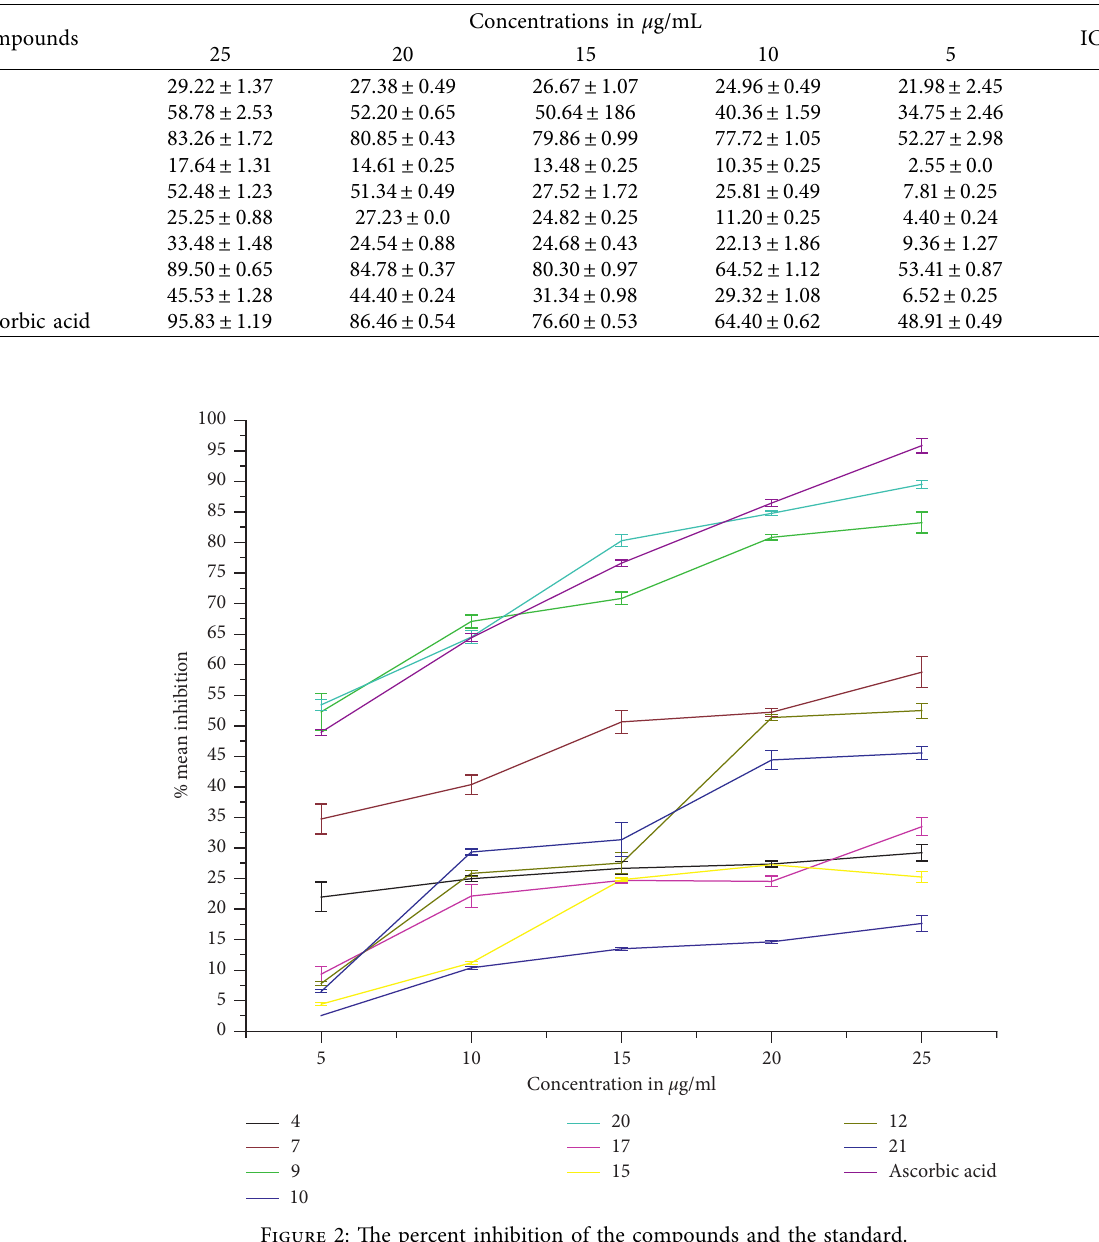
Figure 2: The percent inhibition of the compounds and the